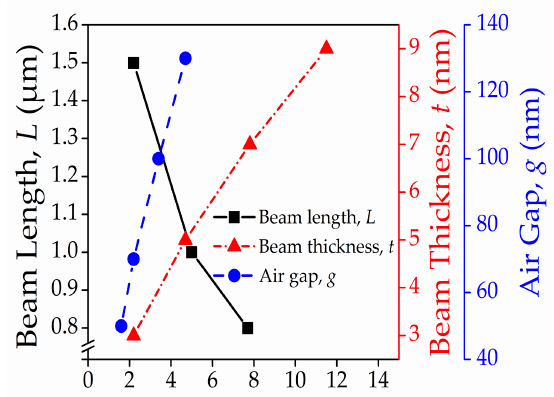
Figure 7. Trends of actuation pull-in voltage against beam length, beam thickness, and air gap thickness of the graphene-based NEM switch device.